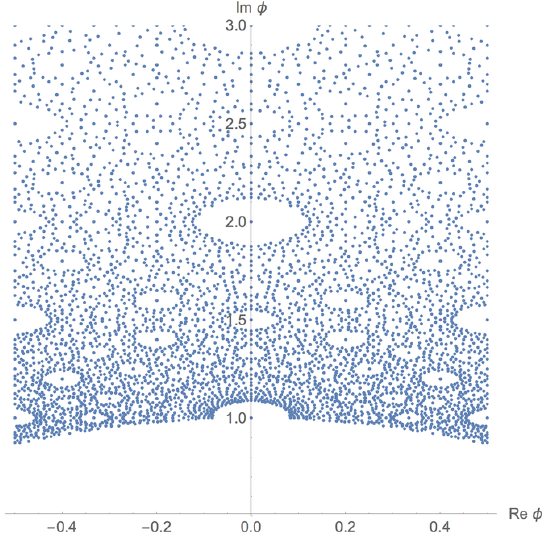
Figure 6 . Rigid Calabi-Yau vacua projected onto axiodilaton with L max = 150. Each point in the diagram represents multiple inequivalent vacua. The relative sizes of the voids depend on number-theoretic aspects of the complex rational value of the axiodilaton at the center.